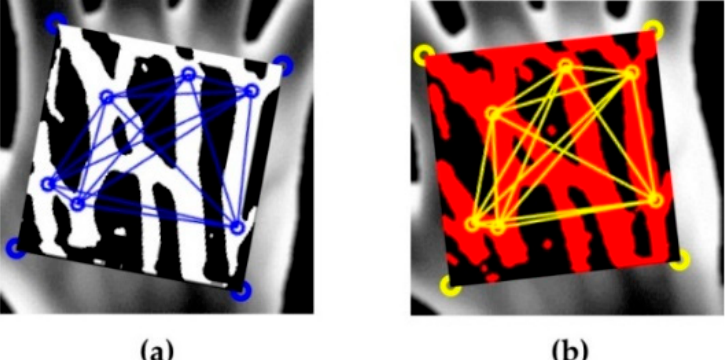
Figure 23. Matching triangles of the template ( a ) and the query ( b ) vein patterns in the presence of affine transformation.